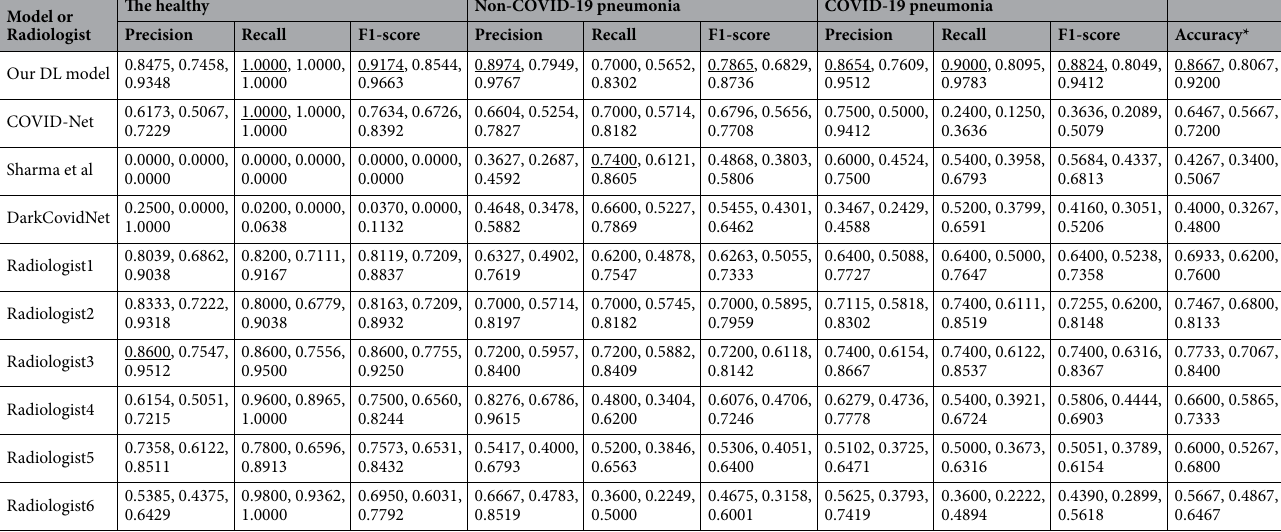
Table 3. Class-wise precision, recall, F1-score, and three-category classification accuracy of four DL models and six radiologists in the COVID private dataset. Each cell includes classification metric and its 95% CI (lower and upper bounds of CI). * indicates 3-category classification accuracy. The experience of the six radiologists were 10 months, and 4, 7, 10, 10, and 15 years. The underlined values represent the best values for each column. DL deep learning; CI confidence interval; COVID private private dataset collected from six